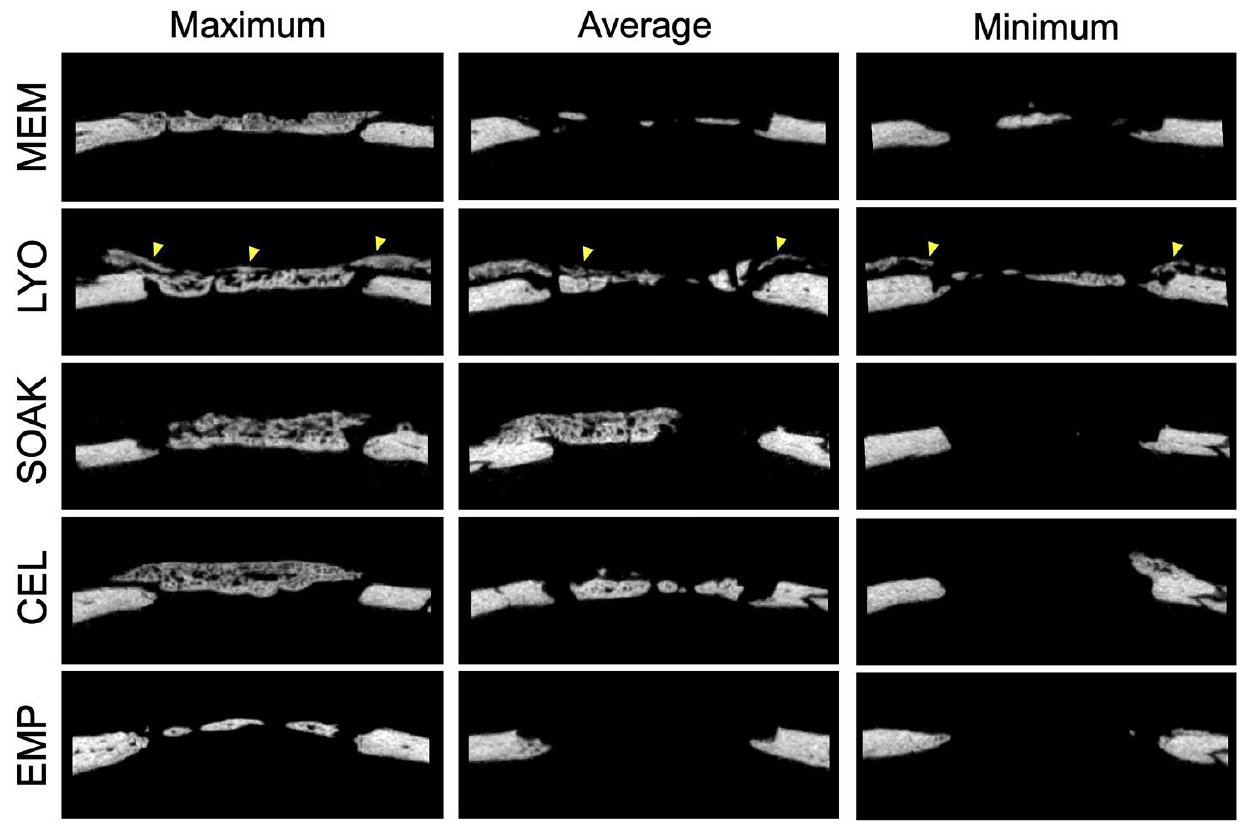
Figure 3. μ CT analysis (continued). Representative μ CT images of central slices at 4 weeks showing maximum, average and minimum bone formation in the different groups. Mineralization within the membrane component is indicated by yellow arrows in the LYO group representing hybrid bone and/or mineralized MEM fibers. MEM, native membrane; LYO, lyophilized membrane with conditioned media; SOAK, soaked membrane with conditioned media; CEL, membrane with rMSC; EMP, empty defects.